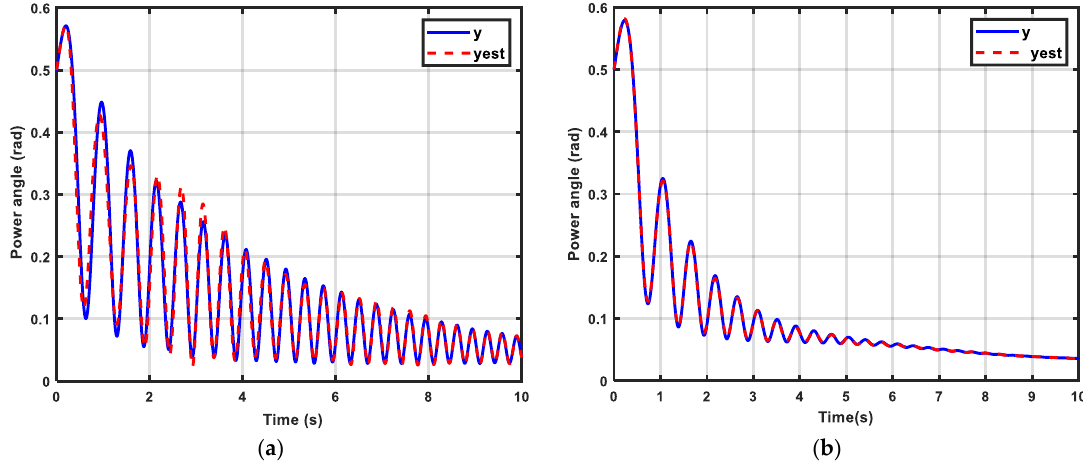
Figure 5. Estimation of system output: ( a ) under actuation fault, ( b ) under fault impact on system dynamics.